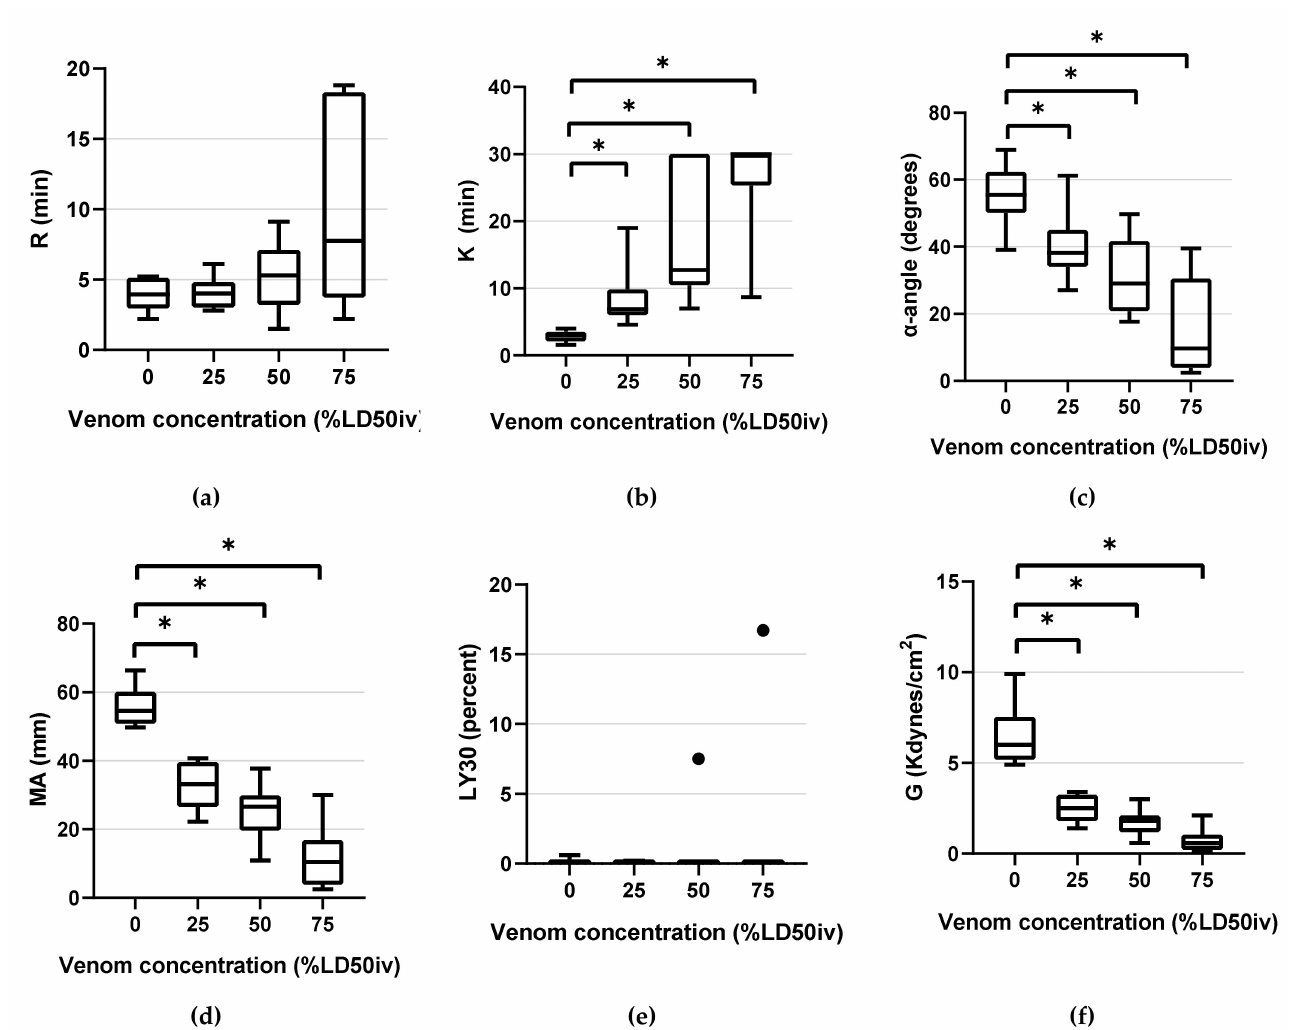
Figure 3. Box-and-whisker plots of TEG parameters: ( a ) R ( b ) K ( c ) α -angle ( d ) MA ( e ) LY30 ( f ) G. Horizontal lines inside the boxes indicate the median. The upper boundary of the boxes indicates the top quartile, whereas the lower boundary indicates the bottom quartile. An asterisk (*) indicates venom concentration (% LD50 iv ) displaying a significant change compared with the control ( p < 0.05). Differences between the 75th and 25th quartiles higher than 1.5-fold are considered as outliers and indicated by a black dot ( • ). R, reaction time; K, kinetic time; α -angle, the rate of clot formation; MA, maximum amplitude; LY30, fibrinolysis at 30 min; and G, global strength of the